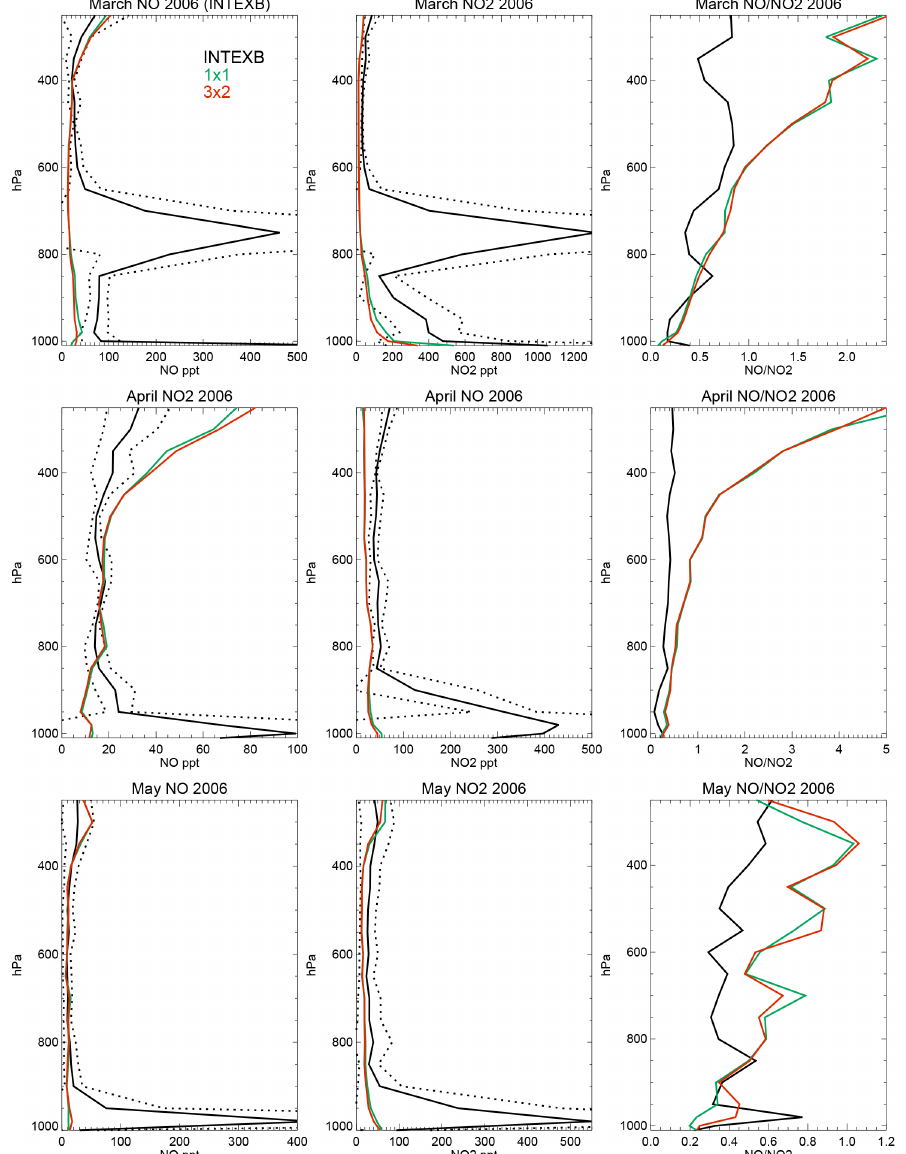
Figure 7. Monthly mean comparisons of NO (left), NO 2 (middle) and the resulting NO / NO 2 ratio (right) from INTEX-B measurements and TM5-MP simulations. The dotted line represents the 1 σ deviation in the mean of the measurements. For details of the locations for each month the reader is referred to Singh et al.